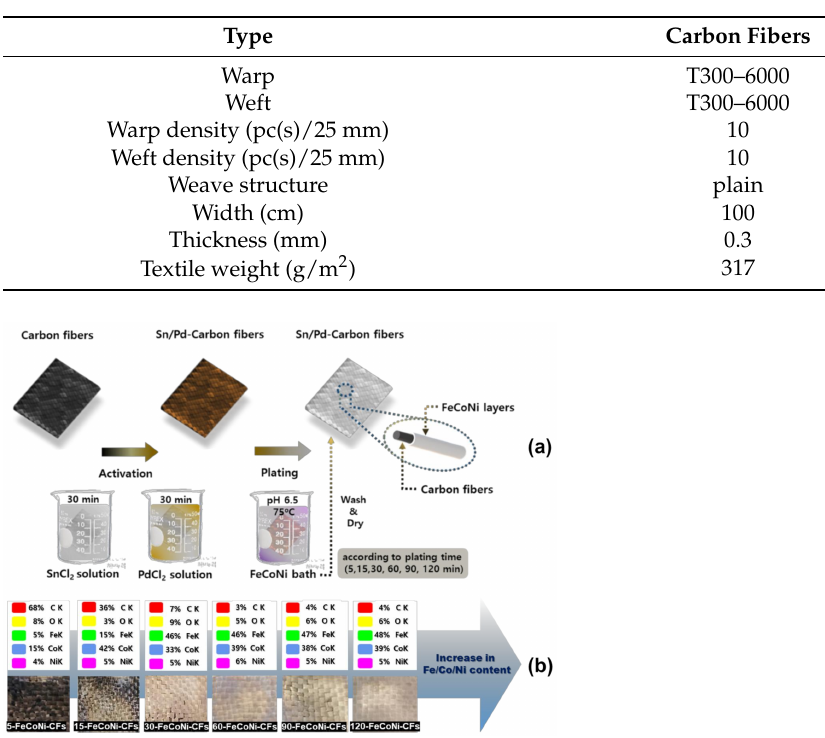
Table 1. Physical properties of carbon fibers.